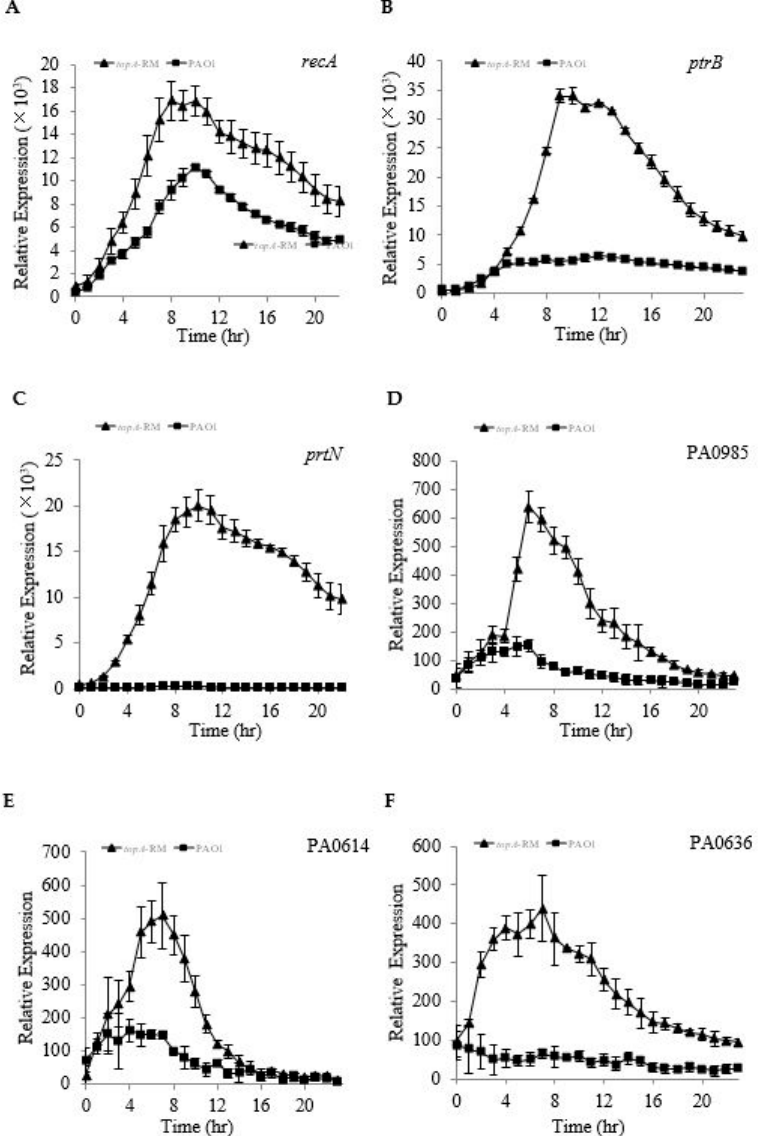
Figure 8. Comparison of expression profiles of the recA ( A ), ptrB ( B ), prtN ( C )and pyocin related genes ( D – F ) in PAO1 and topA -RM. The expression levels are presented as cps normalized to OD 595 . The values in topA -RM are shown as triangles and those in PAO1 as squares (data are shown as averages from triplicate experiments ± standard errors of the means).